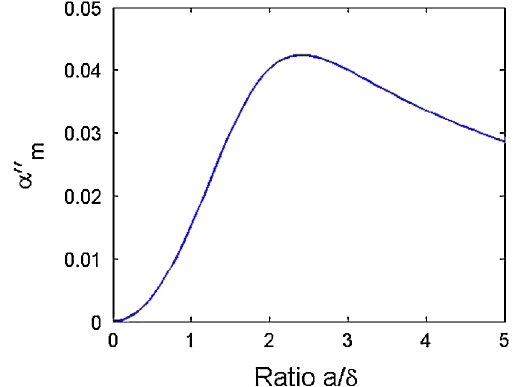
FIG. 1. (Color) Imaginary part of the magnetic polarizability of a small sphere as a function of the ratio of the sphere radius to the skin depth.